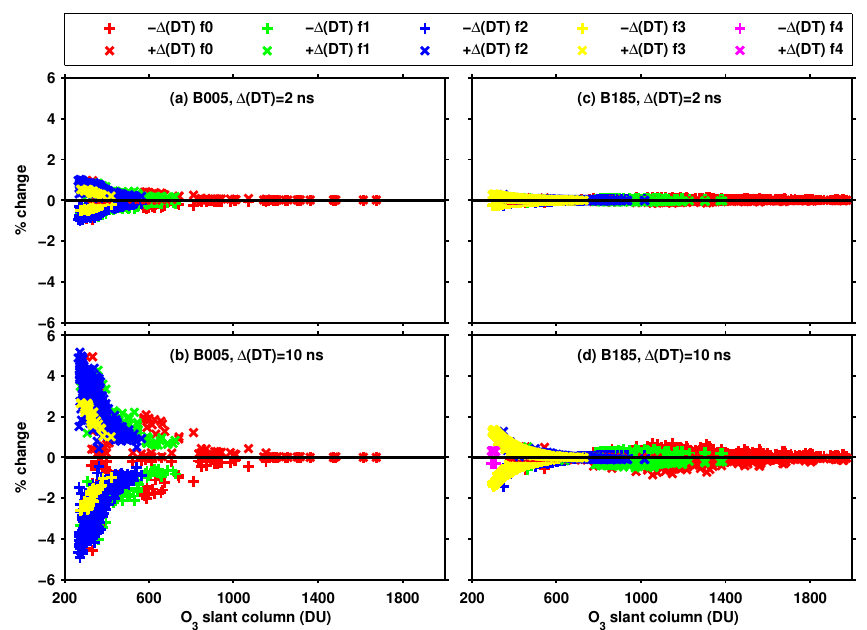
Figure 7. Changes (%) in TOC derived from direct-Sun measurements due to offsetting the DT by ± 2ns (a, c) and ± 10ns (b, d) , as a function of ozone slant column, for B005 (a, b) and B185 (c, d) . Different colors refer to data measured without (red) and with neutral density filters of optical density 0.5 (green), 1 (blue), 1.5 (yellow) and 2 (magenta). The reference DT is 34ns for B005 and 29ns for